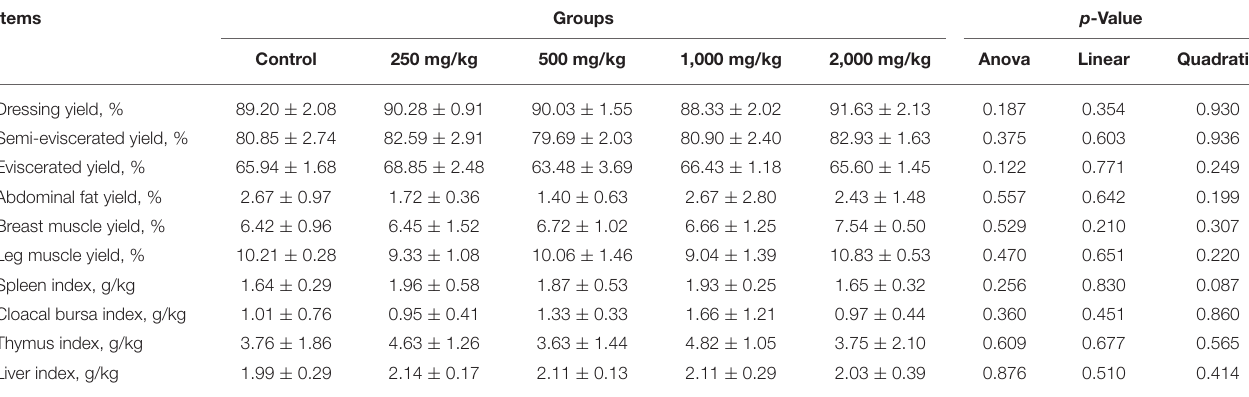
TABLE 3 | Effect of dietary Galla chinensis extract (GCE) supplementation at different levels on carcass traits of broilers.